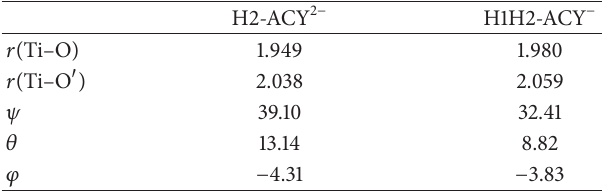
Table 4: Distances, in ˚A, and angles, in o , relevant to the binding through the –COOH group of the dye to the nanocluster. The geometry was optimized at DFT/B3LYP/3-21G(d)